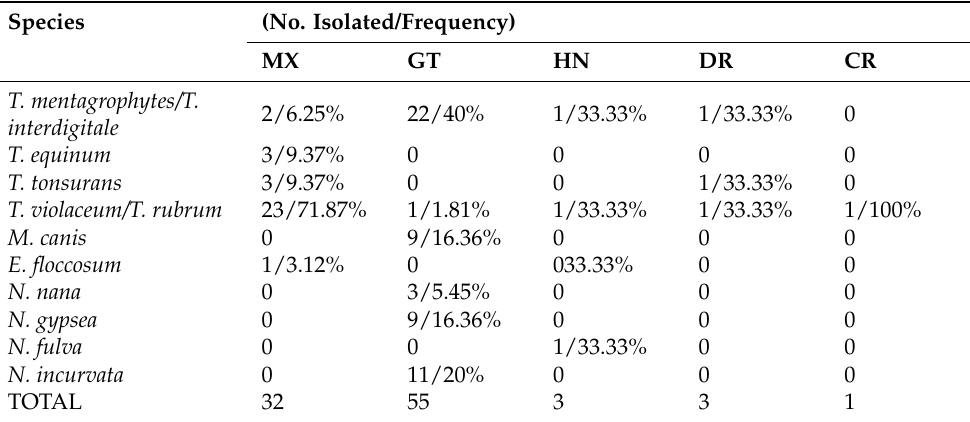
Table 5. Frequency of species genotypically identified using maximum likelihood according to their geographic origin.